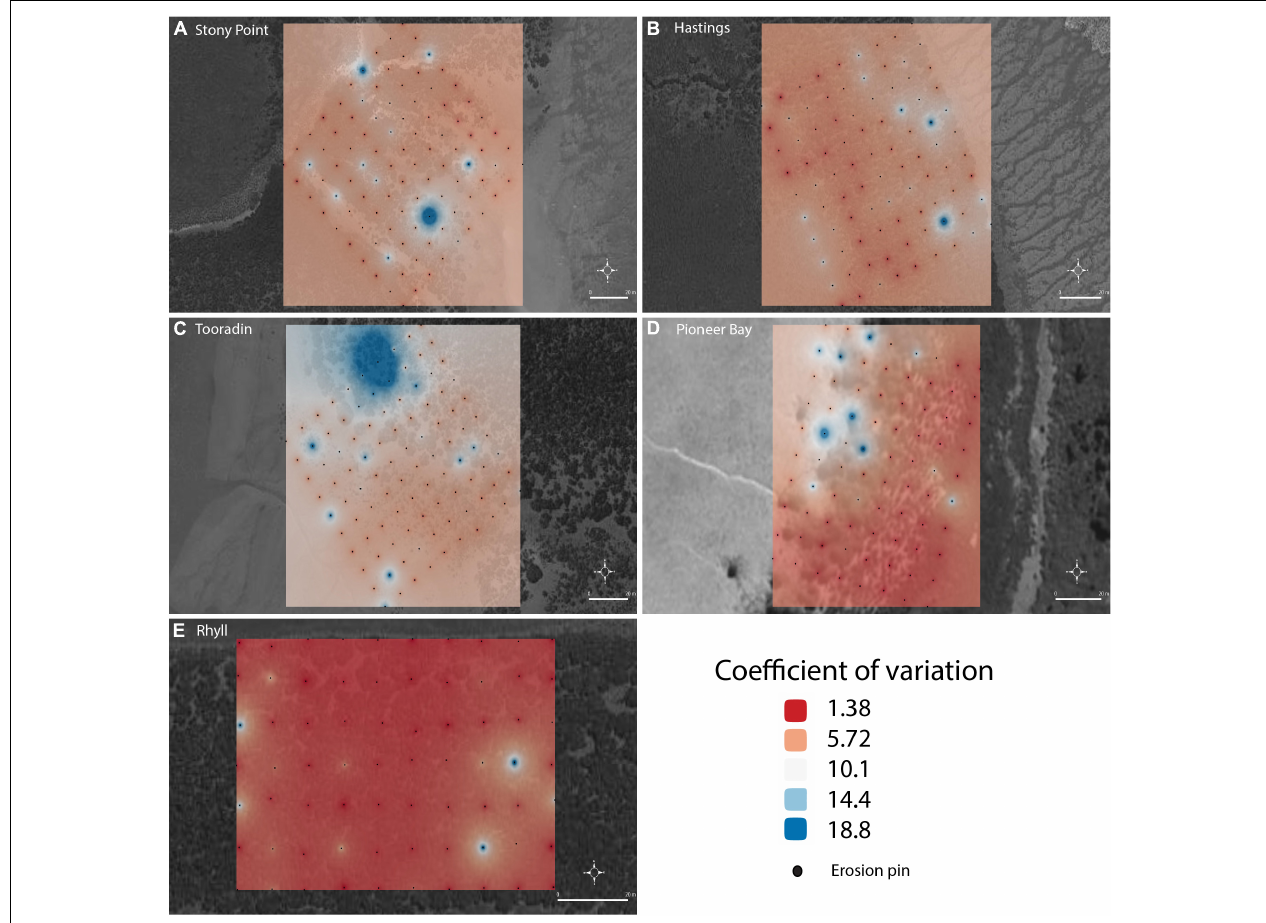
FIGURE 8 | Inter and intra-site measurement coefficient of variation at sites (A) Stony Point, (B) Hastings, (C) , Tooradin, (D) Pioneer Bay, (E)